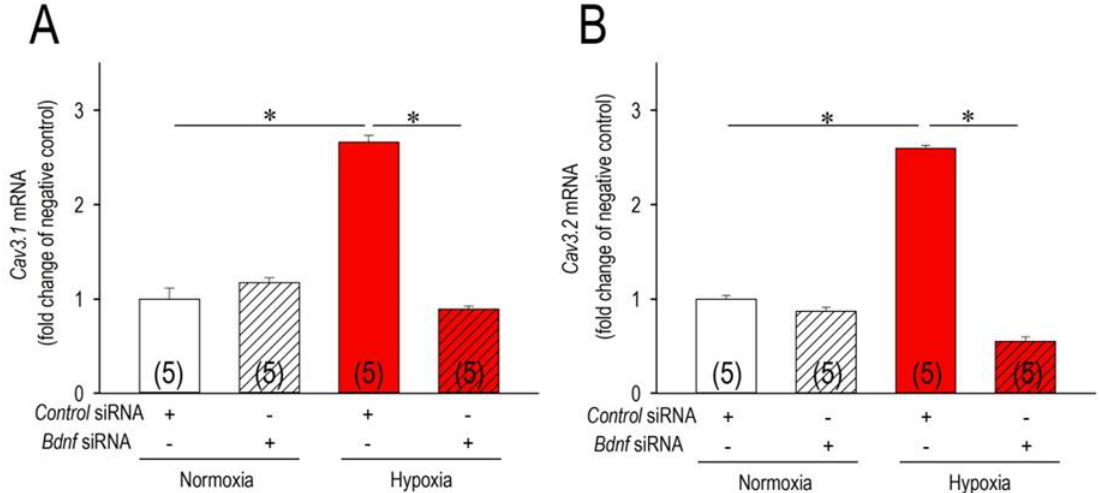
Figure 5. Actions of Bdnf knockout on the expression of Cav3 channels in normoxia and hypoxia. Changes of Cav3.1-mRNA ( A ) and Cav3.2 -mRNA expression ( B ) in cardiomyocytes exposed to normoxia or hypoxia for 3 h, and actions of Bdnf knockout by use of control-siRNA (scramble siRNA, 10 nM) or Bdnf -siRNA (10 nM) transfected with Lipofectamine RNAiMAX for 48 h. After transfection, cardiomyocytes were exposed to normoxia or hypoxia for 3 h, and then assessed by real-time PCR. * p < 0.05, compared with those as indicated. Numbers of experiments are given in parentheses (n=5).